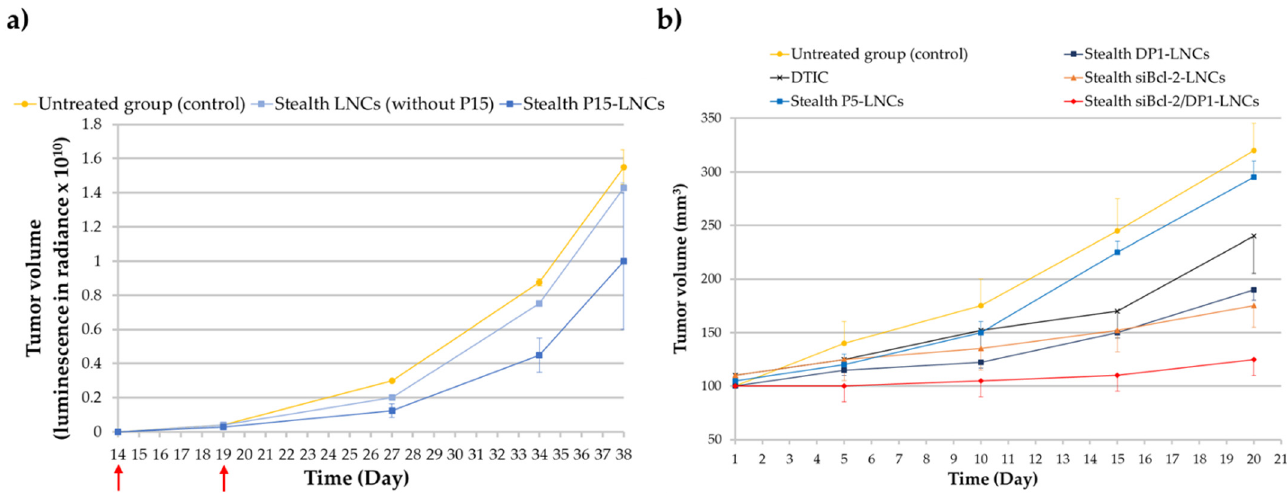
Figure 8. ( a ) Tumor volume evolution after intraperitoneal injections of stealth P15-LNCs in mice bearing ectopic MDA-MB-231 cells. The red arrows indicate the days of treatment. Bioluminescence has been measured in radiance (pixels/second/cm 2 /square) in order to obtain the tumor volume (adapted with permission from [55], Copytight 2021 Elsevier); ( b ) tumor volume evolution after repeated intravenous injections of stealth DP1-LNCs (blue dark square), P5-LNCs (blue square), dacarbazine/DTIC (dark cross), stealth siBcl-2-LNCs (orange triangle) and stealth siBcl-2/DP1-LNCs (red diamond) on SK-Mel28 cells bearing mice. The abscissa axis starts after the treatment injections (adapted with permission from [59], Copytight 2021 Elsevier).